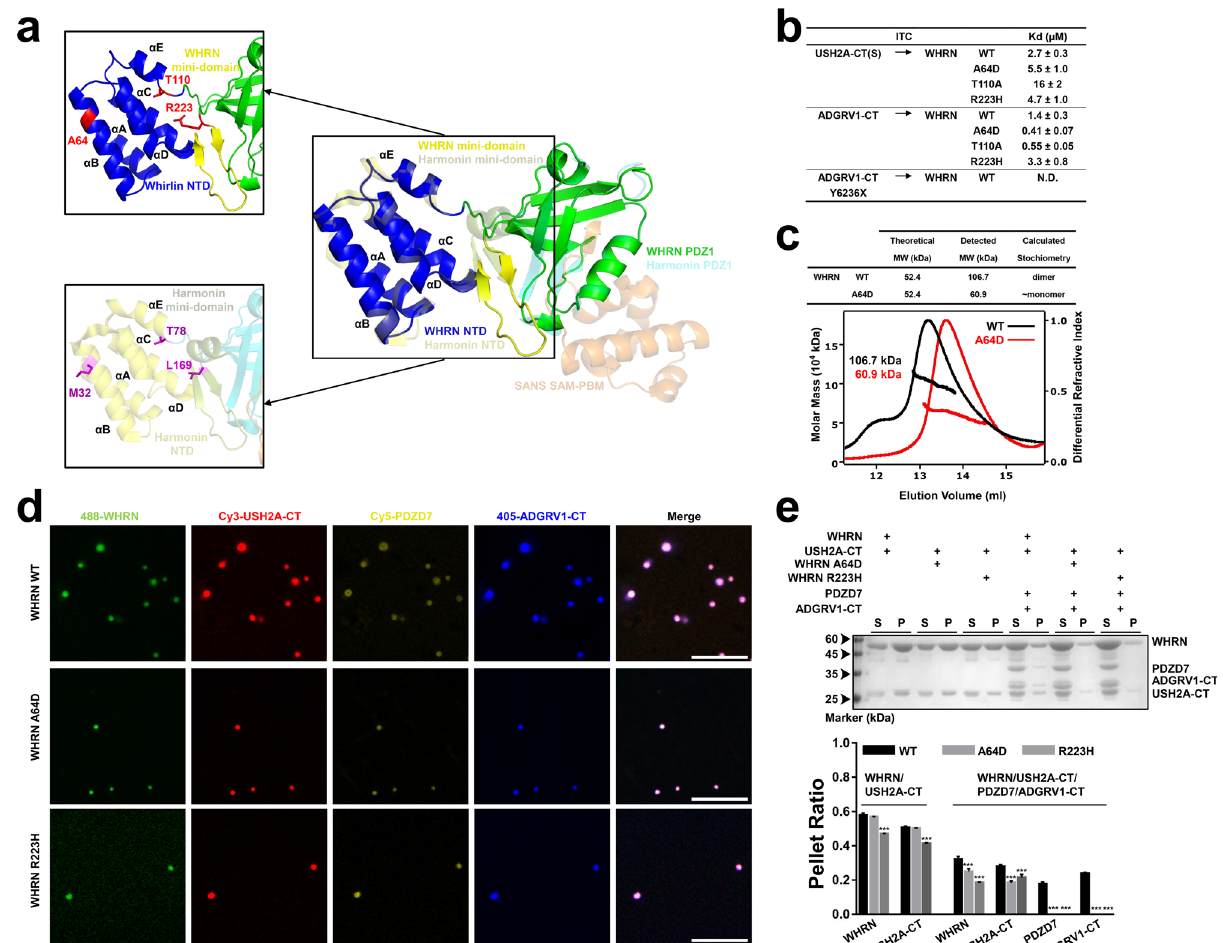
Fig.8|Deafness-relatedmutationsonWHRNaffecttheLLPScapacitiesofUSH2 proteins. a The predicted WHRN NPDZ1 structure is superimposed with the resolved structure of Harmonin NPDZ1/SANS SAM-PBM 29 . Superimposition shows that A64, T110, and R223 on WHRN NPDZ1 correspond to M32, T78, and L169 on Harmonin NPDZ1, respectively. The side chain of WHRN A64 points outwards. A64D may disturb WHRN dimerization by disrupting WHRN NTD oligomerization. WHRNT110localizestothe α EhelixofNTD.WespeculatethattheT110Amayaffect WHRN ’ s interaction with USH2A by disrupting the overall conformation of WHRN. WHRN R223 localizes on the mini-domain. We speculate that R223H disrupts the overallfolding of themini-domainandfurtherleadstothemisfoldingofNPDZ1on WHRN. b Summaries of the binding af fi nities between WT or deafness-related mutants of WHRN, ADGRV1-CT, and USH2A-CT. N.D. not detectable. c Up panel, a